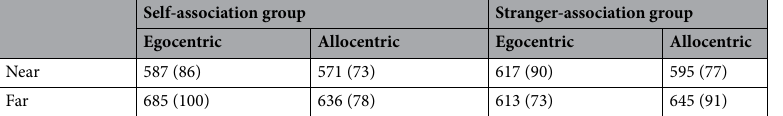
between groups and reference frame judgment tasks was significant, F (1,97) = 4.89, p = 0.03, η p 2 = 0.05. The inter- action effect between the spatial domains and reference frame judgment tasks was not significant, F (1,97) = 1.12, p = 0.29. The three-way interaction effect among groups, spatial domains, and reference frame judgment tasks was significant, F (1,97) = 4.59, p = 0.04, η p 2 = 0.05. To investigate the potential interaction between ownership groups and reference frames in near and far spaces, further simple effect analyses should be conducted. First, to examine the role of groups in the three-way interaction effect, 2 (spatial domains: near vs. far) × 2 (ref- erence frame judgment tasks: allocentric vs. egocentric) repeated ANOVA was conducted in the self-association group and stranger-association group. For the self-association group, the main effect of spatial domains was significant, F (1,49) = 25.57, p < 0.001, η p 2 = 0.33, and the RTs of near-space processing (579 ms) were significantly faster than those of far-space processing (606 ms). The main effect of reference frame judgment tasks was signifi- cant, F (1,49) = 6.35, p = 0.02, η p 2 = 0.12, and the RTs of the allocentric judgment task (583 ms) were significantly faster than those of the egocentric judgment task (602 ms). The interaction effect between spatial domains and reference frame judgment tasks was not significant, F < 1. To examine whether the participants performed bet- ter in allocentric judgment tasks in near space or egocentric judgment tasks in far space, a paired sample t test was conducted in the self-association group. The RTs of the allocentric judgment task in near space (571 ms) were faster than those of the egocentric judgment task in far space (617 ms), t (50) = 5.02, p < 0.001, Cohen’s d = 0.56. For the stranger-association group, the main effect of spatial domains was significant, F (1,48) = 38.62,